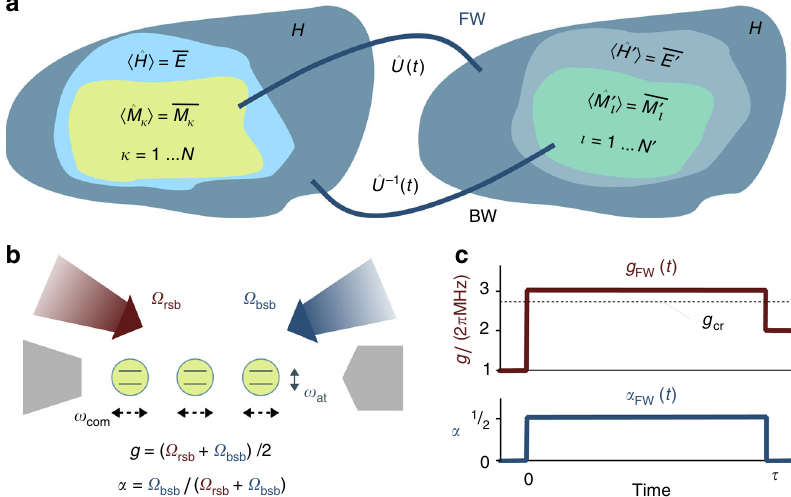
D E Fig. 1 Sketch of the system and protocol. ( a ) The dynamics of a generic quantum system with average energy ^ H ¼ E occurs within a restricted subspace (light blue area) of its full Hilbert space, H (dark blue). If additional conserved quantities exist, the dynamics is further restricted to a smaller subspace (yellow). An equilibrium state of such a system with charges is described by a generalised Gibbs ensemble density matrix, Eq. (1). Here, we consider two unitary processes ^ U ð t Þ ; ^ U (cid:2) 1 ð t Þ that drive the system out of two such equilibrium states corresponding to Hamiltonians ^ H and ^ H ′ , respectively. b Trapped ion setup: N ions (circles) equally coupled to a phonon mode (black arrows) are illuminated by fi elds addressing the red and blue sidebands (wide red and blue arrows) with Rabi frequency Ω rsb [ Ω bsb ]. c Time dependence of the Dicke model parameters in the forward (FW) protocol, with a variable wait time τ between two